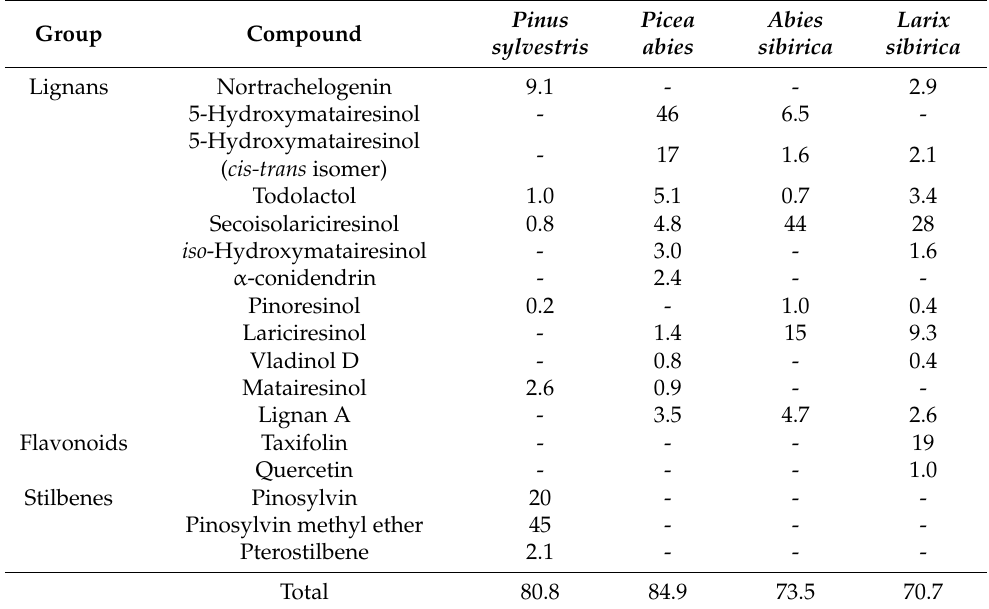
Table 3. Polyphenolic compounds tentatively identified in the knotwood extracts by 2D-NMR and their relative contents (%, of the total aromatics